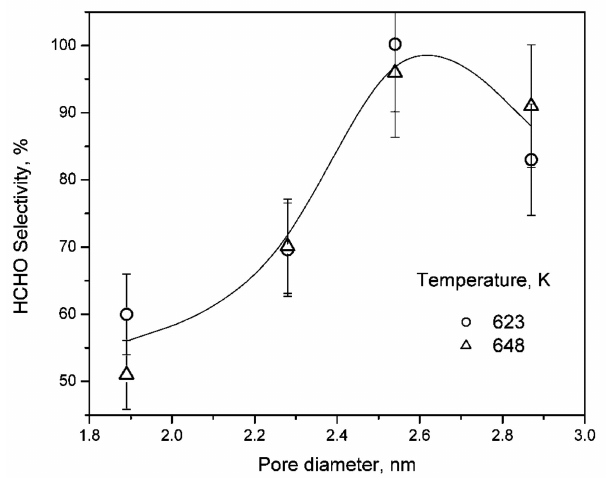
Figure 27. Selectivity of MeOH oxidation to FA as function of pore diameter in V-MCM-41 catalyst at 350 ◦ C and 375 ◦ C in a feed of 3 vol.% MeOH and 3 vol.% O 2 in He. Reprinted from [170] Copyright © (2005), with permission from